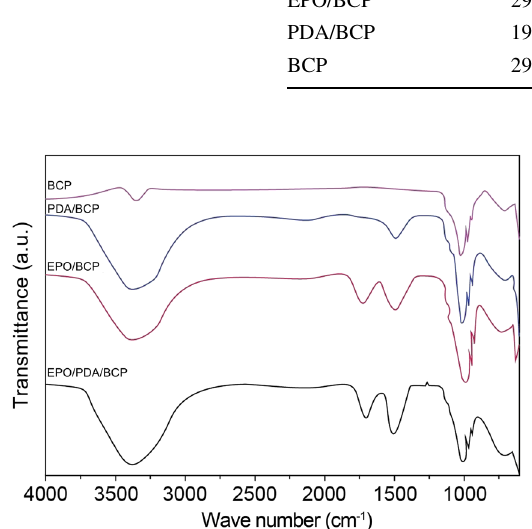
Fig. 3 FTIR analysis of the surface-modi fi ed and unmodi fi ed BCP